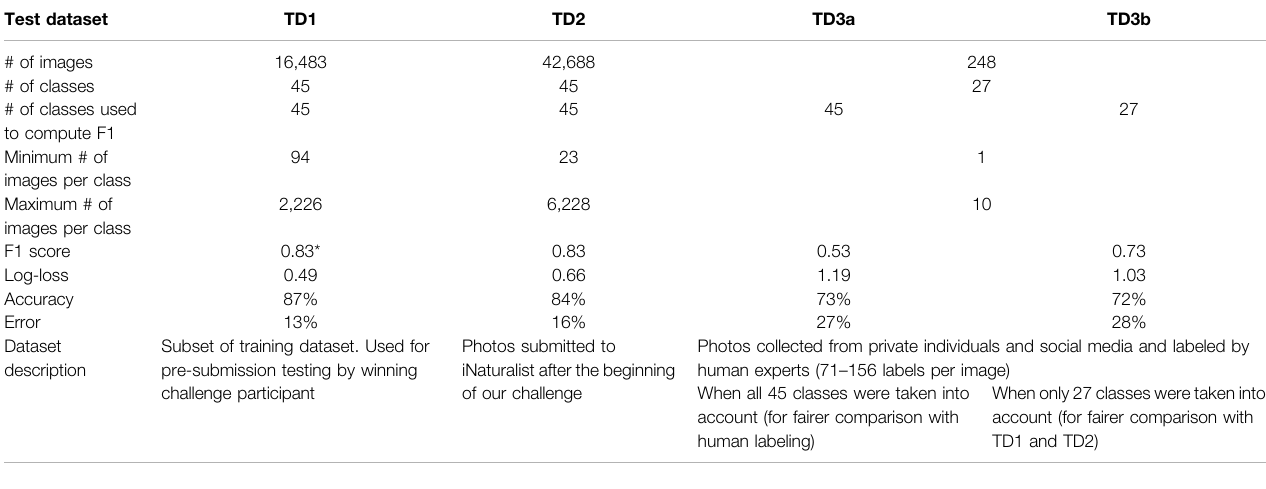
TABLE 1 | Summary of three test datasets used to evaluate identi fi cation accuracy of top algorithm. Performance of humans on TD3a yielded F1 (cid:1) 0.76, accuracy (cid:1) 68%, error (cid:1) 32%, and on TD3b F1 (cid:1) 0.79, accuracy (cid:1) 79%, error (cid:1) 21%. *The winning F1 high score of 0.861 reported above comes from a different randomly generated subset, not reported here in detail.